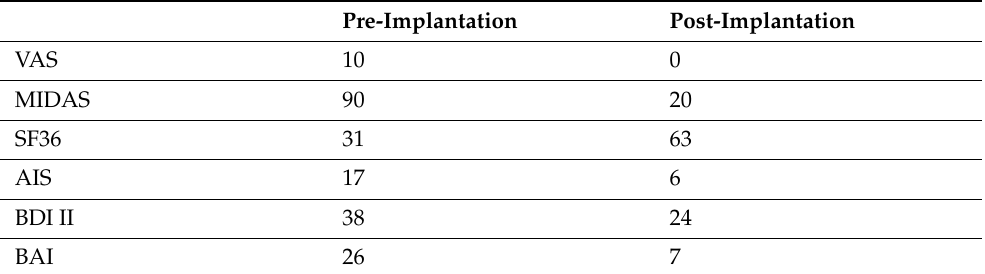
Table 1. Pre- and post-implantation performance (3 months before and 3 months after the combined PNS application), regarding the severity of headache, disability due to headache, quality of life, insomnia, depression, and